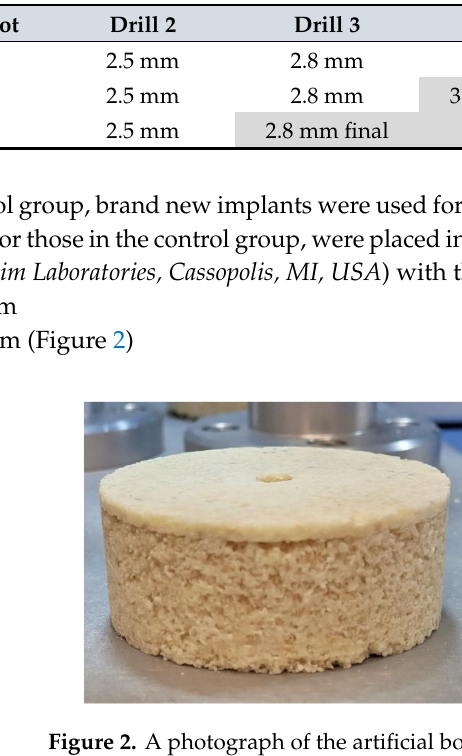
Figure 2. A photograph of the artificial bone.